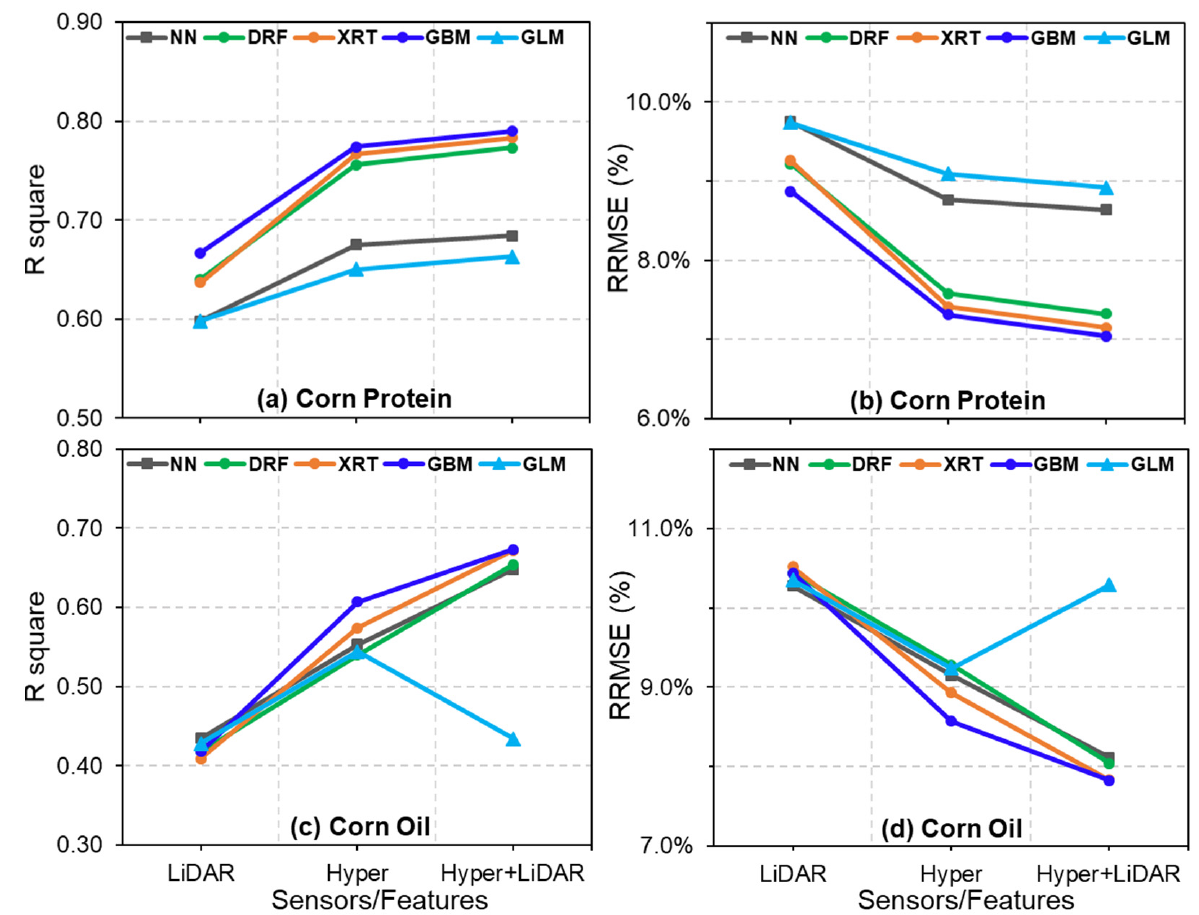
Figure 14. R 2 and RRMSE metrics when predicting corn protein and oil composition based on Hyper- spectral, LiDAR and Hyper + LiDAR data using different machine-learning methods. (R 2 : Coefficients of Determination, RRMSE: Relative Root Mean Square Error; NN: Deep Neural Network, DRF: Distributed Random Forest, XRT: Extremely Randomized Trees, GBM: Gradient Boosting Ma- chine and GLM: Generalized Linear Model).